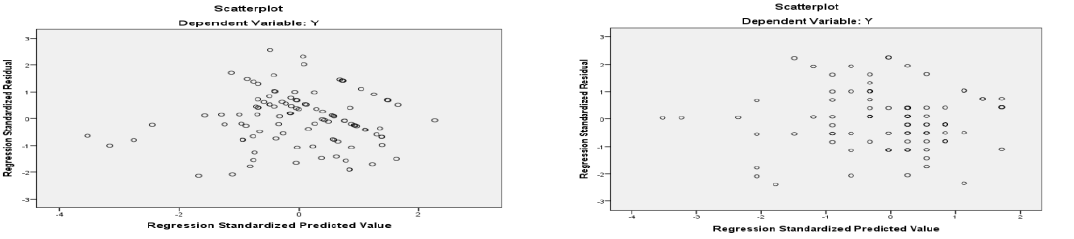
Figure 3: Heterocedasticity test results of regression models I and II; Source: Primary data processed 2019